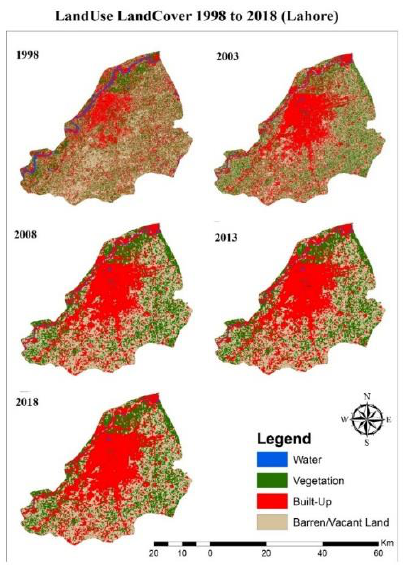
Figure 2: Land use land cover variation for Lahore 1998-2018 Table 3: variations and trends of different land use classes in Lahore 1998-2018. 1998